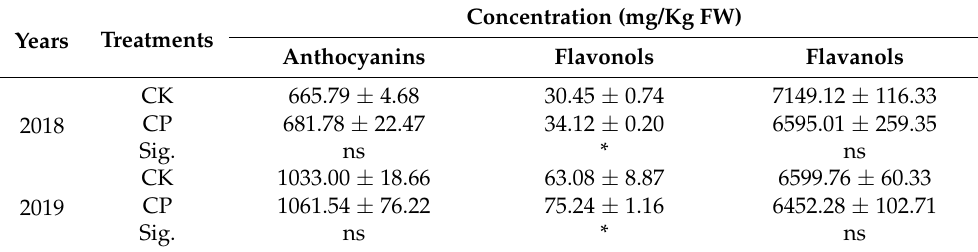
Table 3. Effect of covering purslane on the flavonoid compounds of ‘Cabernet Sauvignon’